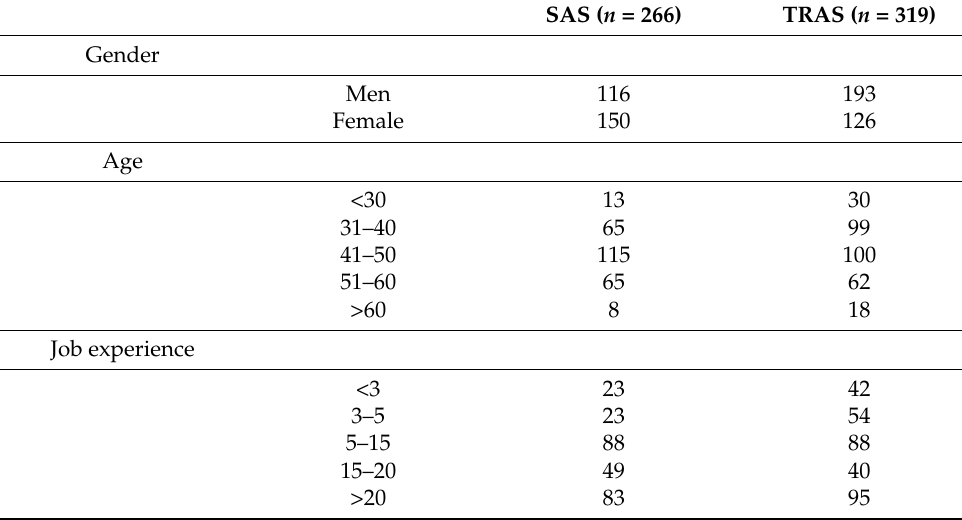
Table 1. Demographic